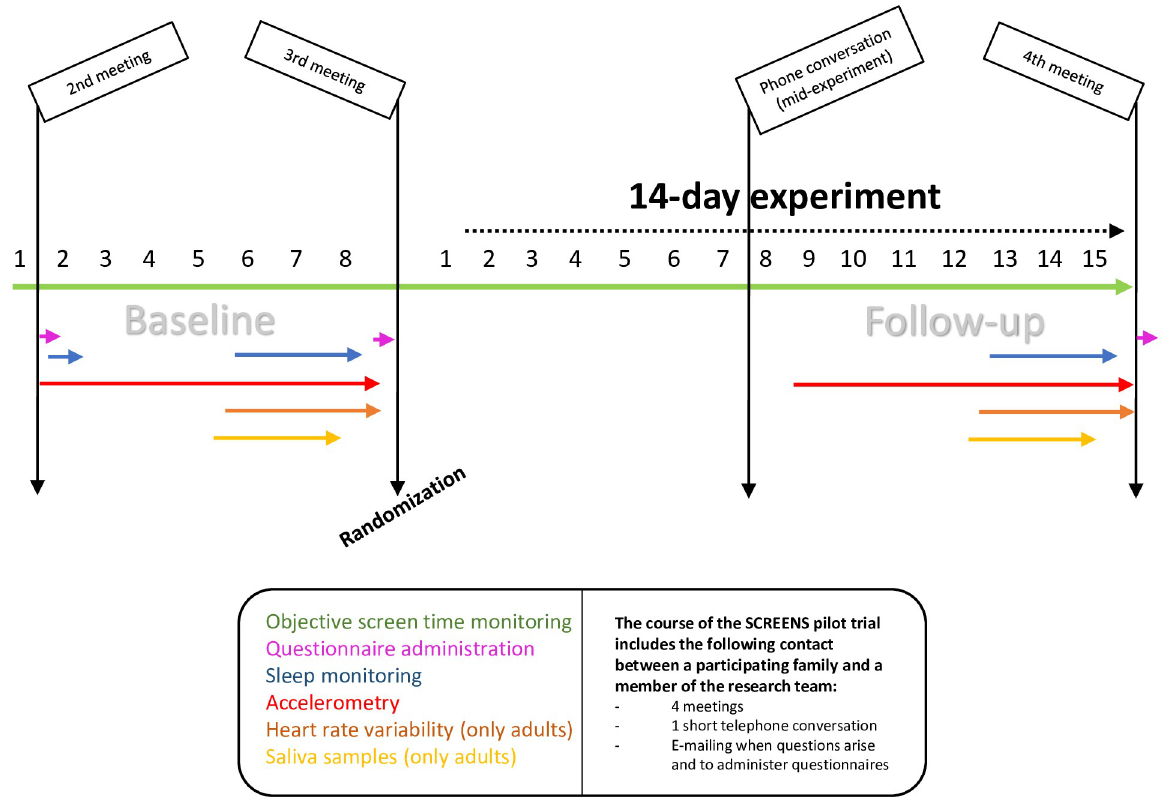
Fig 2. Meeting schedule and measurement protocol. The figure above illustrates the final structure of the trial in days regarding scheduled meetings, as well as the timing of exposure and outcome measurements. The program is structured such that baseline and follow-up commence on the same day of the week, so the data will be collected on the same days. Note that the only difference between baseline and follow-up is that at baseline a test sleep measurement is included during the first night. The 1 st meeting (not shown above) is a mandatory information meeting, prior to the trial. Also, adults completed questionnaires at baseline addressing; mental well-being, mood state, and bodily pain and discomfort. Following baseline, a questionnaire was administrated regarding the families’ experience with the baseline measurement protocol. The figure above is re-used from another publication (see